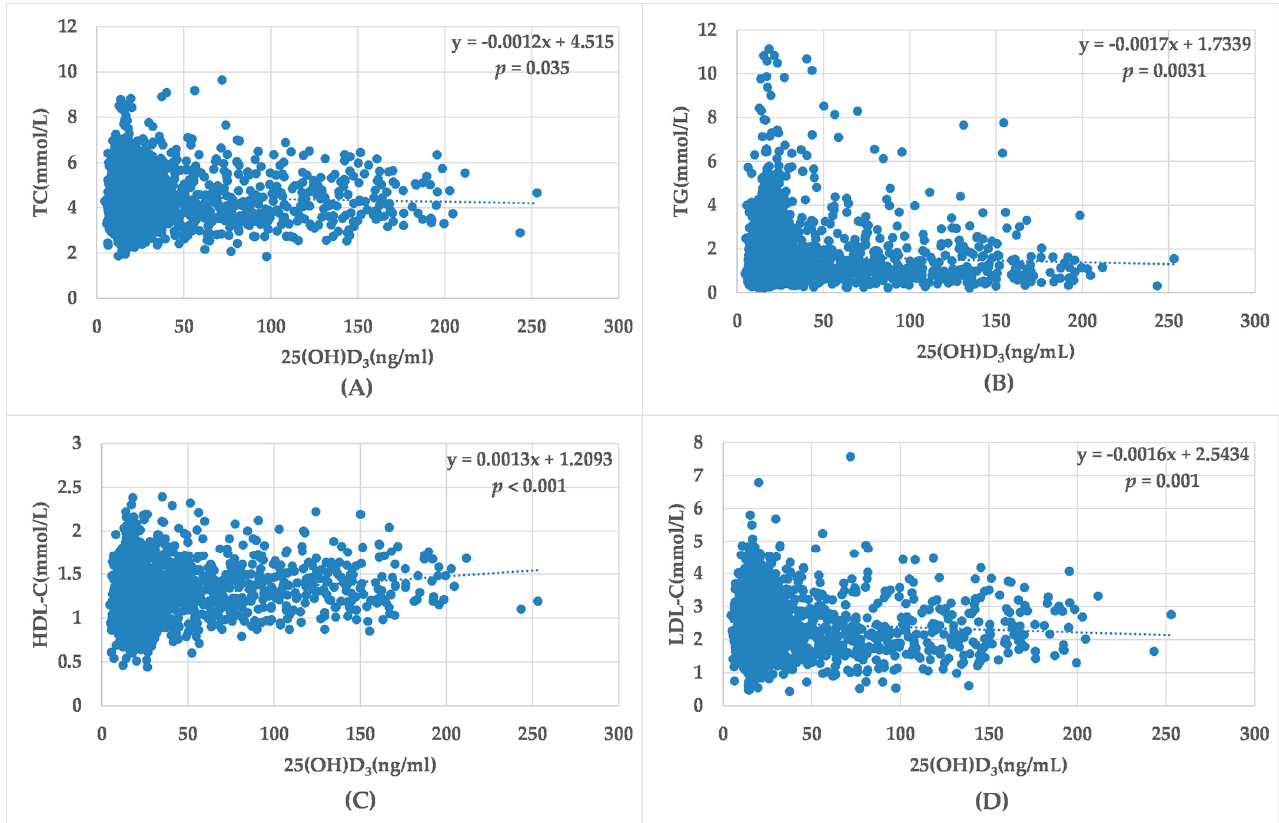
Figure 4. Simple linear correlation between serum lipids and 25(OH)D 3 level. Simple linear correlation between TC ( A ), TG ( B ), HDL-C ( C ), LDL-C ( D ) and 25(OH)D 3 level. TC (the cholesterol), TG (triglyceride), HDL-C (high-density lipoprotein- cholesterol), LDL-C (low-density lipoprotein-cholesterol).